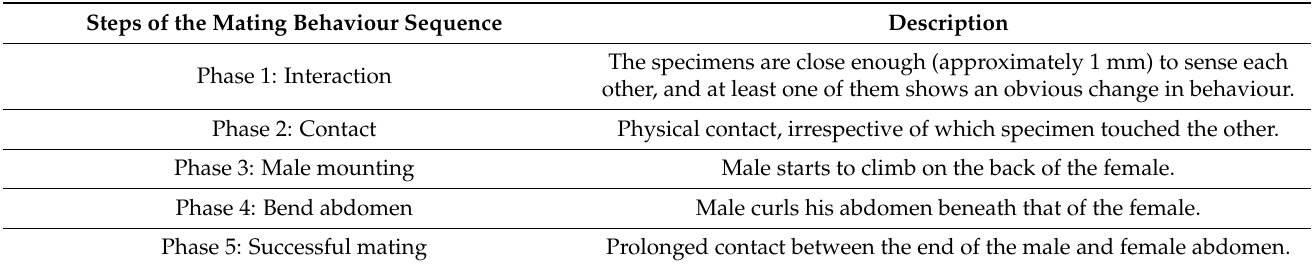
Table 1. Mating behaviour sequence in the Thrips tabaci species